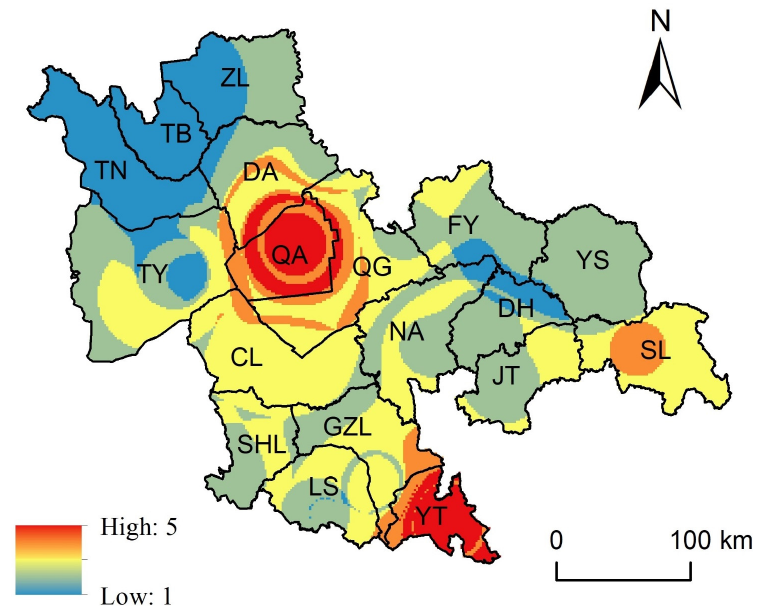
Figure 5. Drought hazard level of the study area.